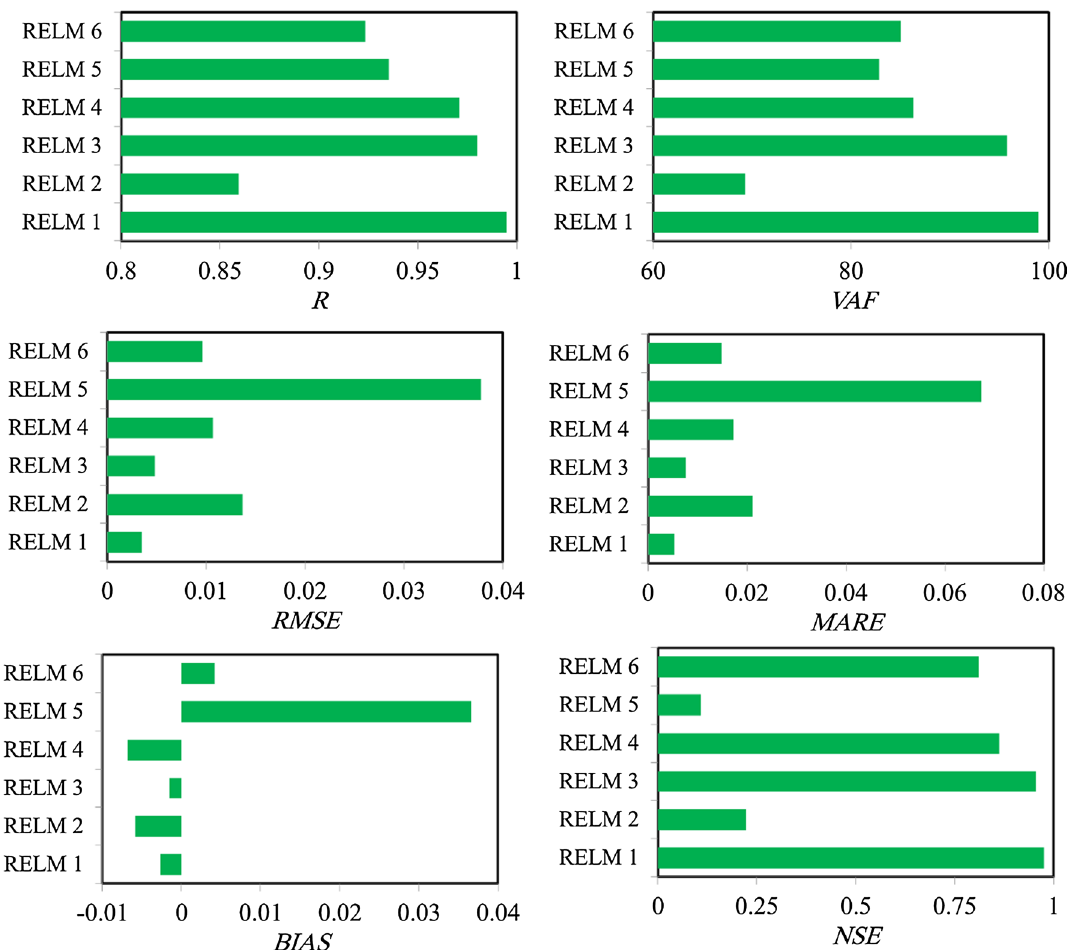
Fig. 11 Values of statistical indices for RELM1 to RELM6